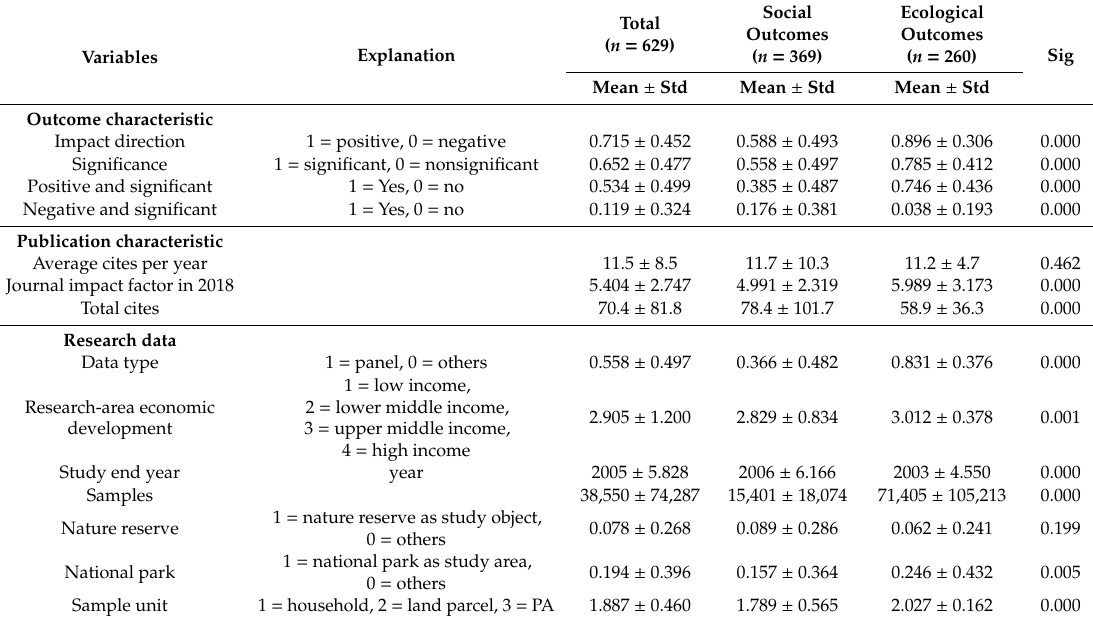
Table 2. Descriptive analysis of main variables.